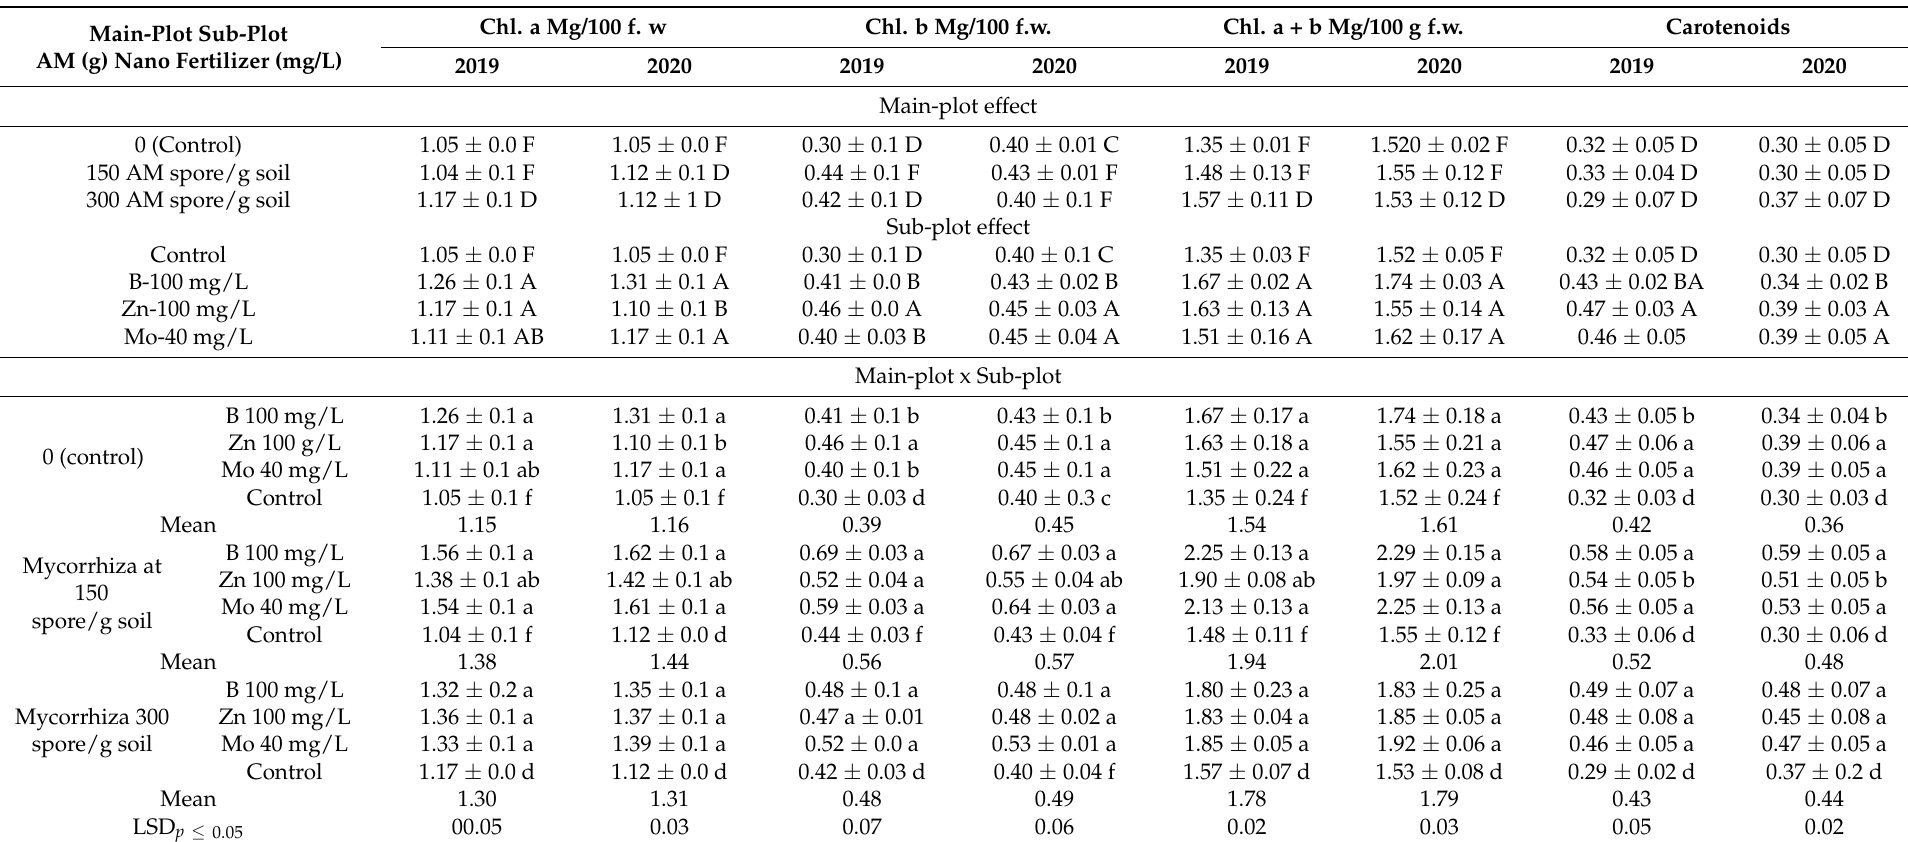
Table 3. Effect of arbuscular mycorrhiza (AM) and nano B, Zn, and Mo microelements on chlorophyll contents of stevia leaves at 70 days after transplanting during 2019 and 2020 seasons. Main-Plot